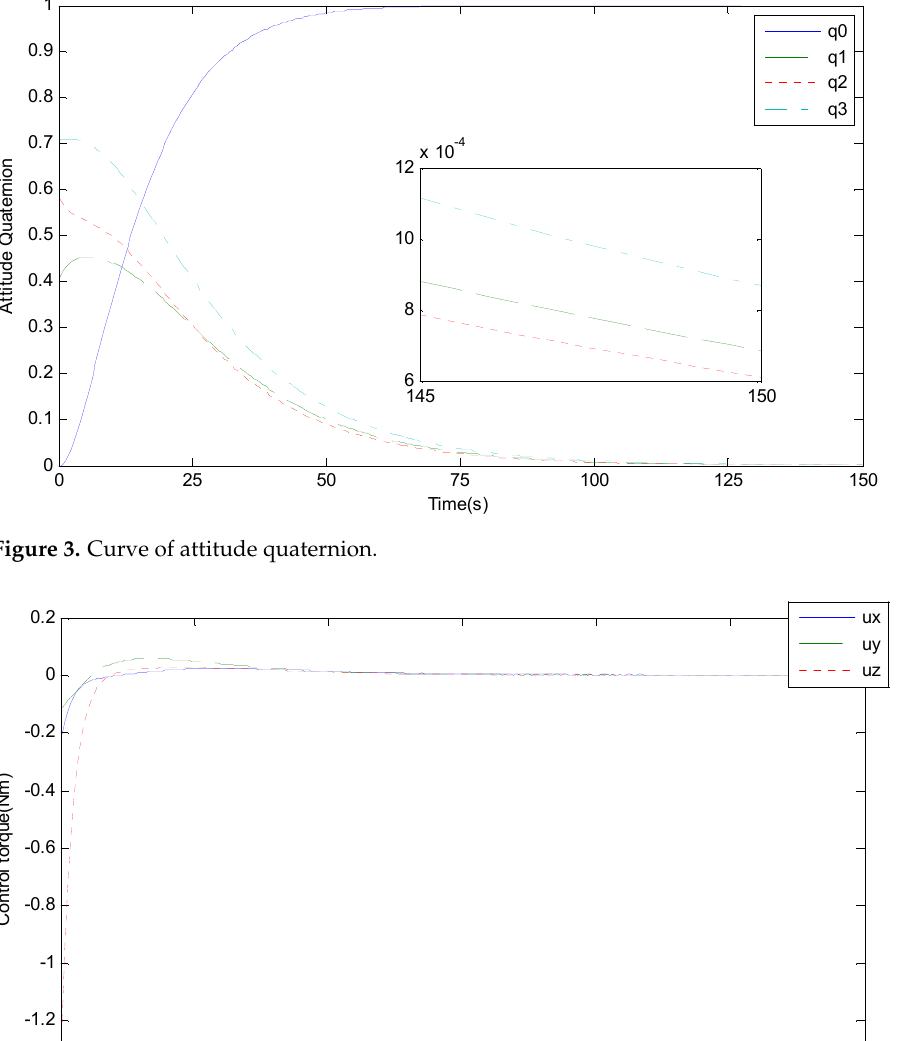
Figure 2. Curve of angular velocity.